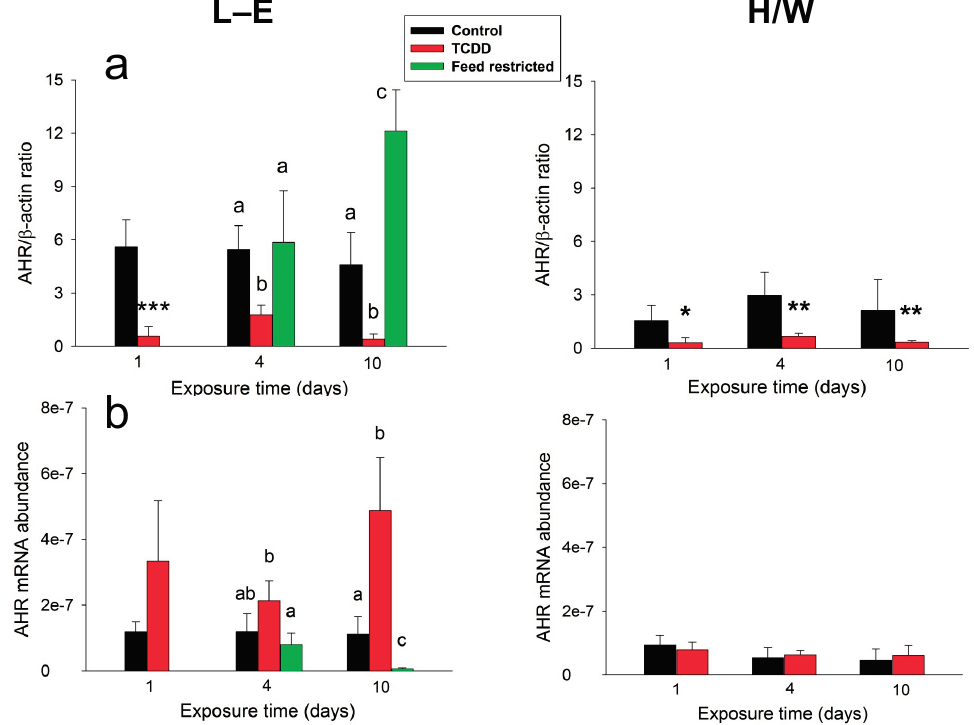
Figure 9. The effect of TCDD or feed restriction on liver AHR ( a ) protein and ( b ) mRNA levels in L-E ( left panel) and H/W rats ( right panel) as a function of time (mean ± SD). The conditions are as in Figure